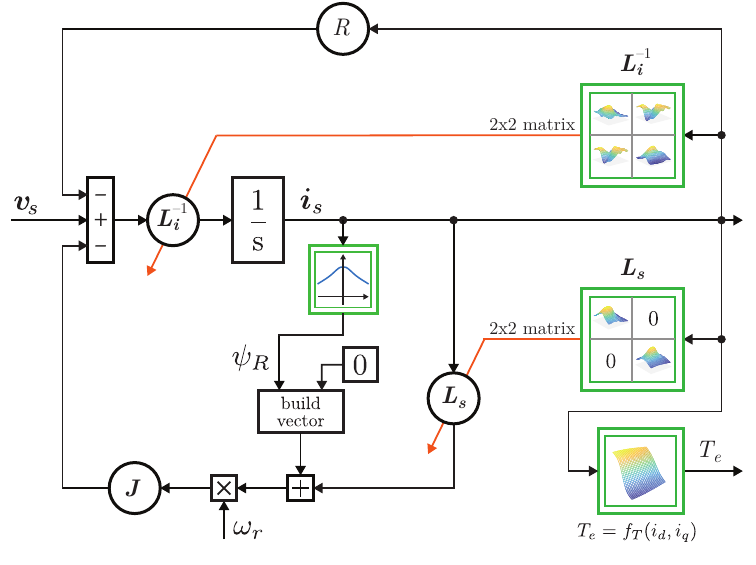
Figure 1. Block diagram of nonlinear current model (CM).